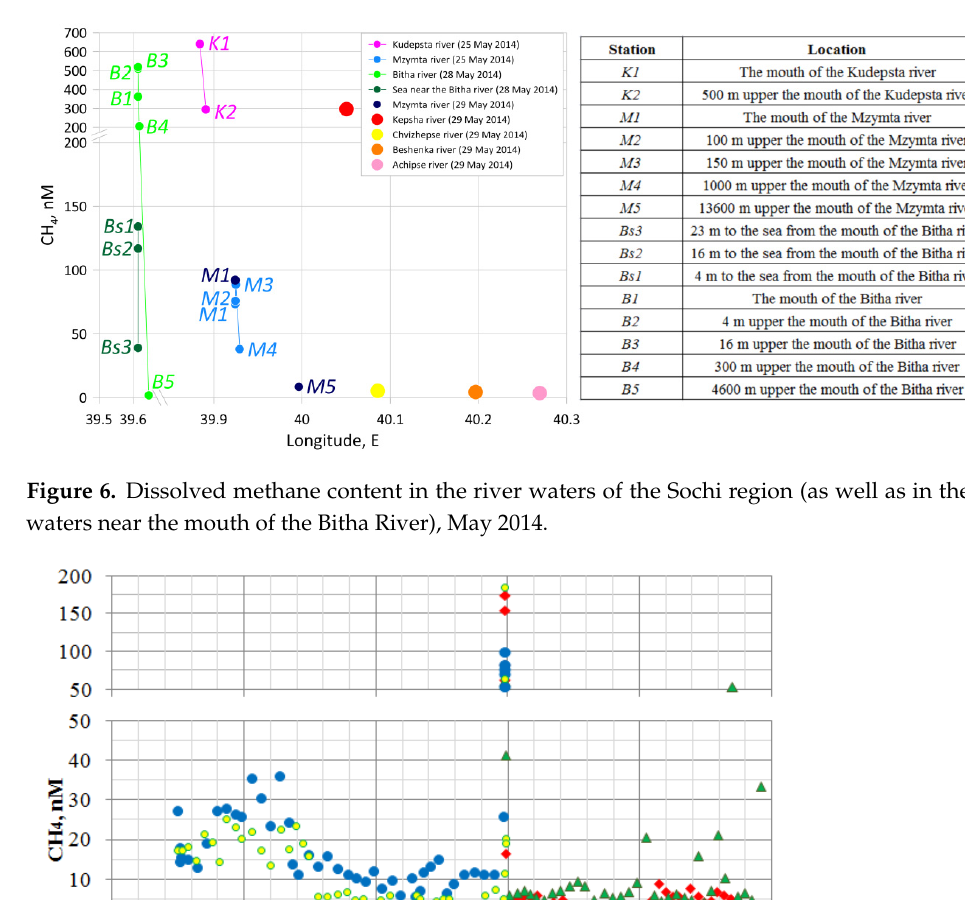
Figure 6. Dissolved methane content in the river waters of the Sochi region (as well as in the sea waters near the mouth of the Bitha River), May 2014.